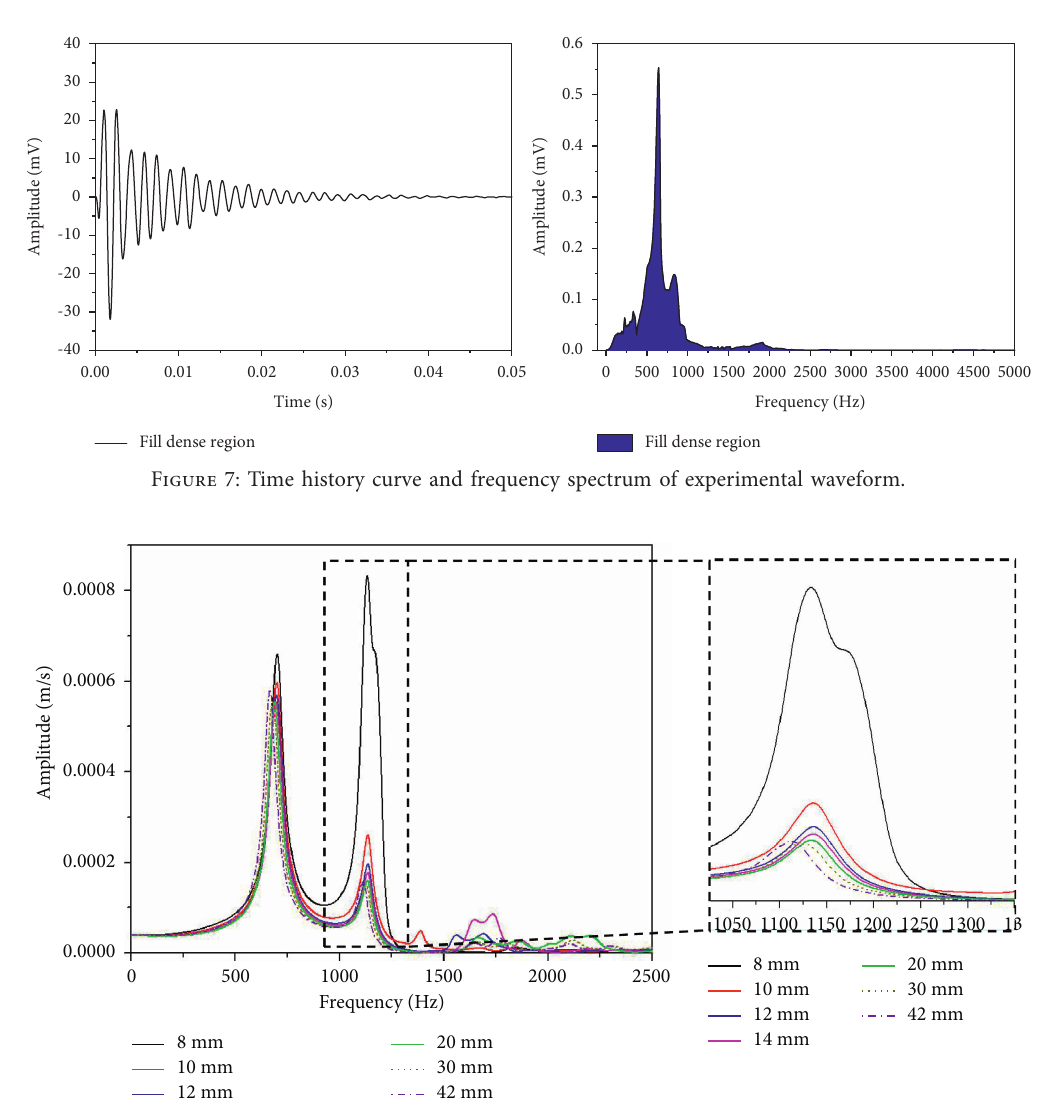
Figure 6: Time history curve and frequency spectrum of numerical simulation waveform.